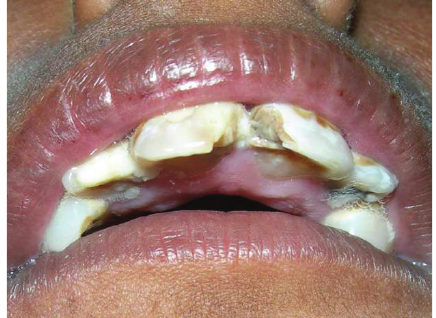
Figure 3: It shows the dental condition 2 years back.